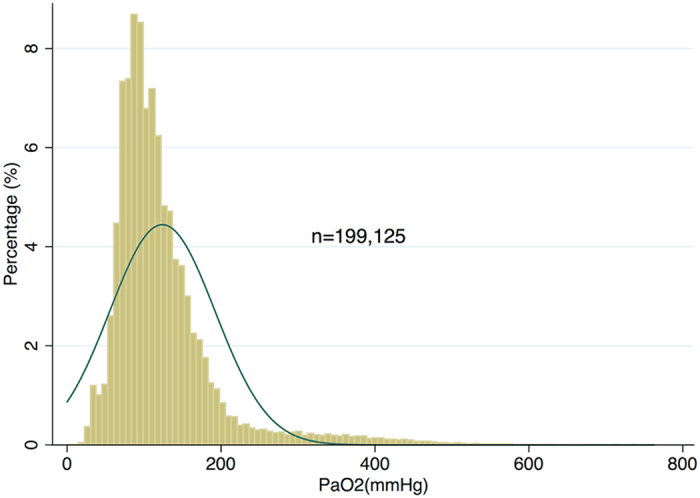
Histogram showing the distribution of arterial oxygen partial pressure (PaO2) in our cohort (n = 199,125).It appears that PaO2 is approximately normally distributed with the mean value around 100 mmHg.